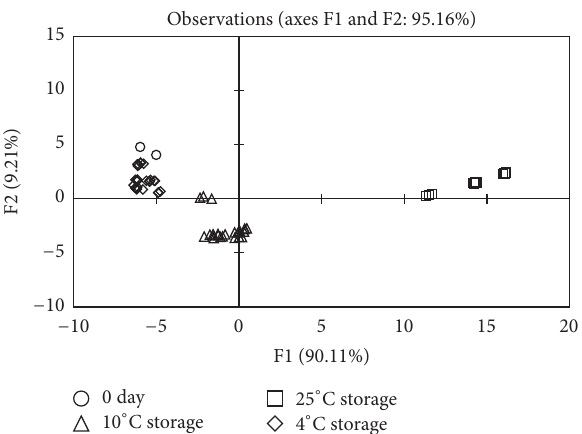
Figure 1: Distinction of kimchi samples at each storage temperature (0 days, 4 ∘ C, 10 ∘ C, and 25 ∘ C) by the organic acid content of each group using linear discriminant analysis